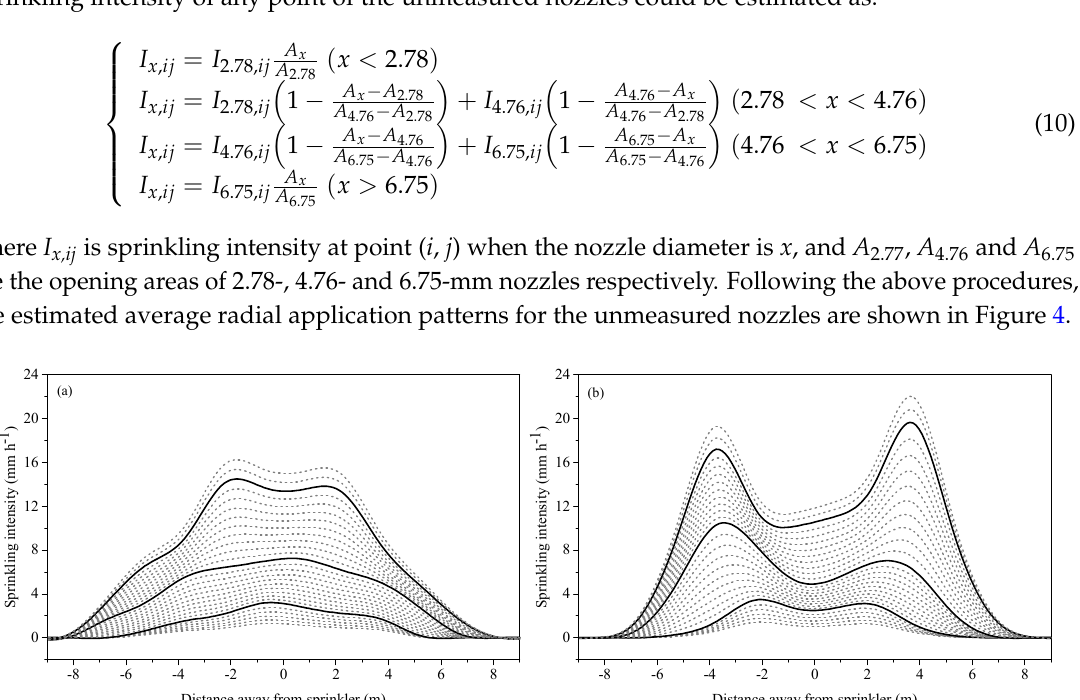
RSPSs ( a ) and FSPSs ( b ). The three solid lines in each figure indicated the three actual measured